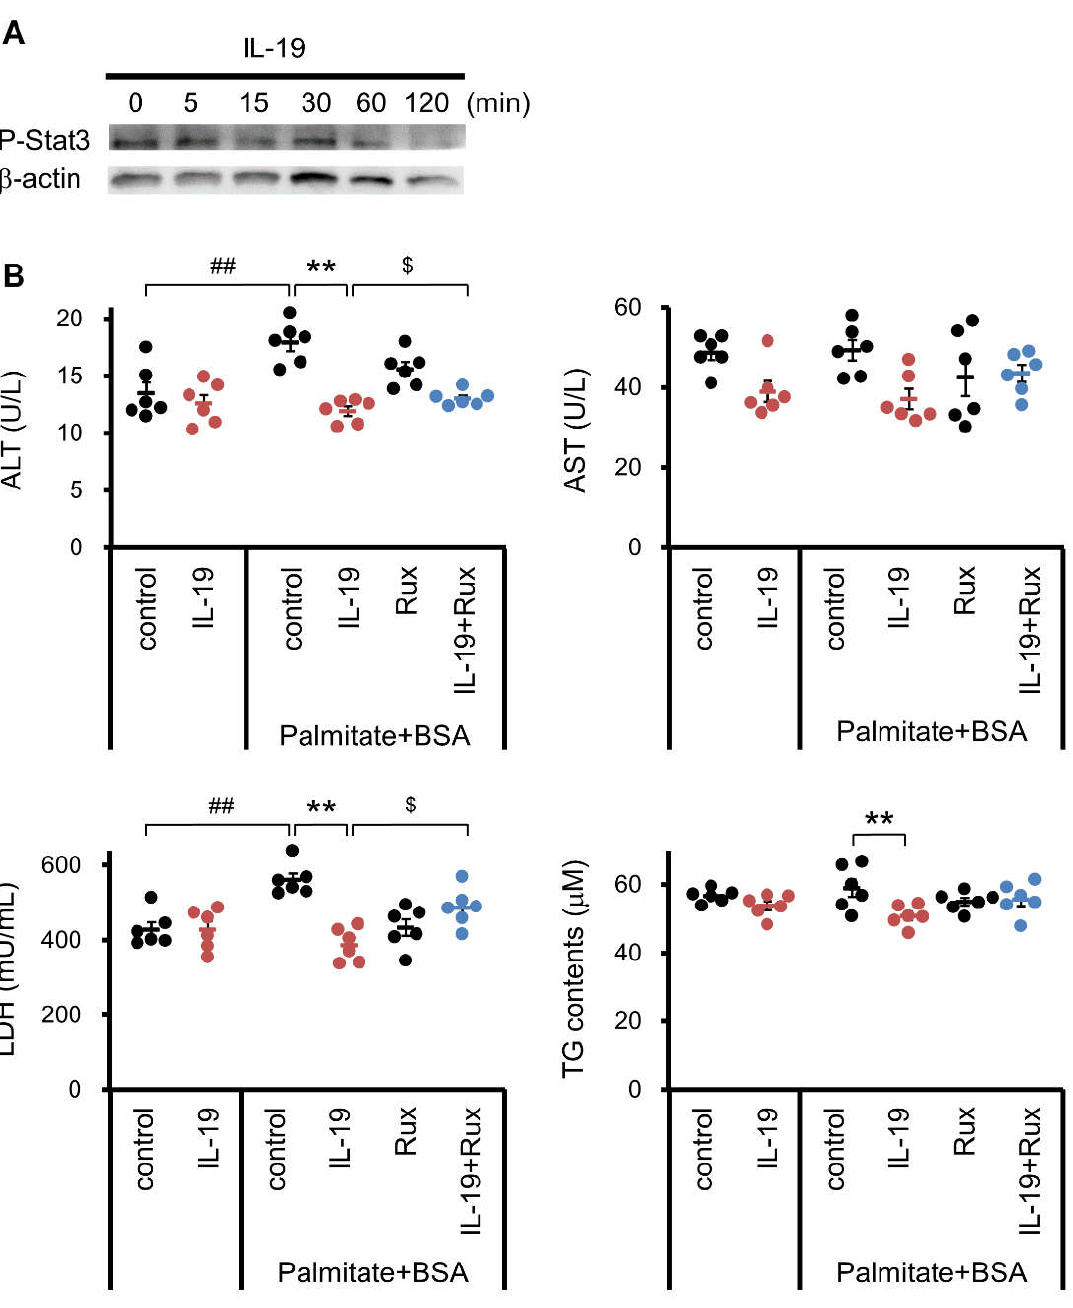
Figure 8. Various responses of primary hepatocytes that respond to IL-19. ( A ) Primary hepatocytes were treated with 100 ng/mL IL-19. Total cell lysates were prepared and blotted with antibody against the phosphorylated form of STAT3. Representative images are shown ( n = 4). ( B ) Primary hepatocytes were treated with 200 µ M palmitate-BSA, 100 ng/mL IL-19, and 2 µ M ruxolitinib for 48 h. The ALT and AST levels were measured ( n = 6). The LDH levels were measured ( n = 6). The TG levels were measured using ( n = 6). ## p < 0.01 vs. BSA. ** p < 0.01 vs. control. $ p < 0.05 vs.